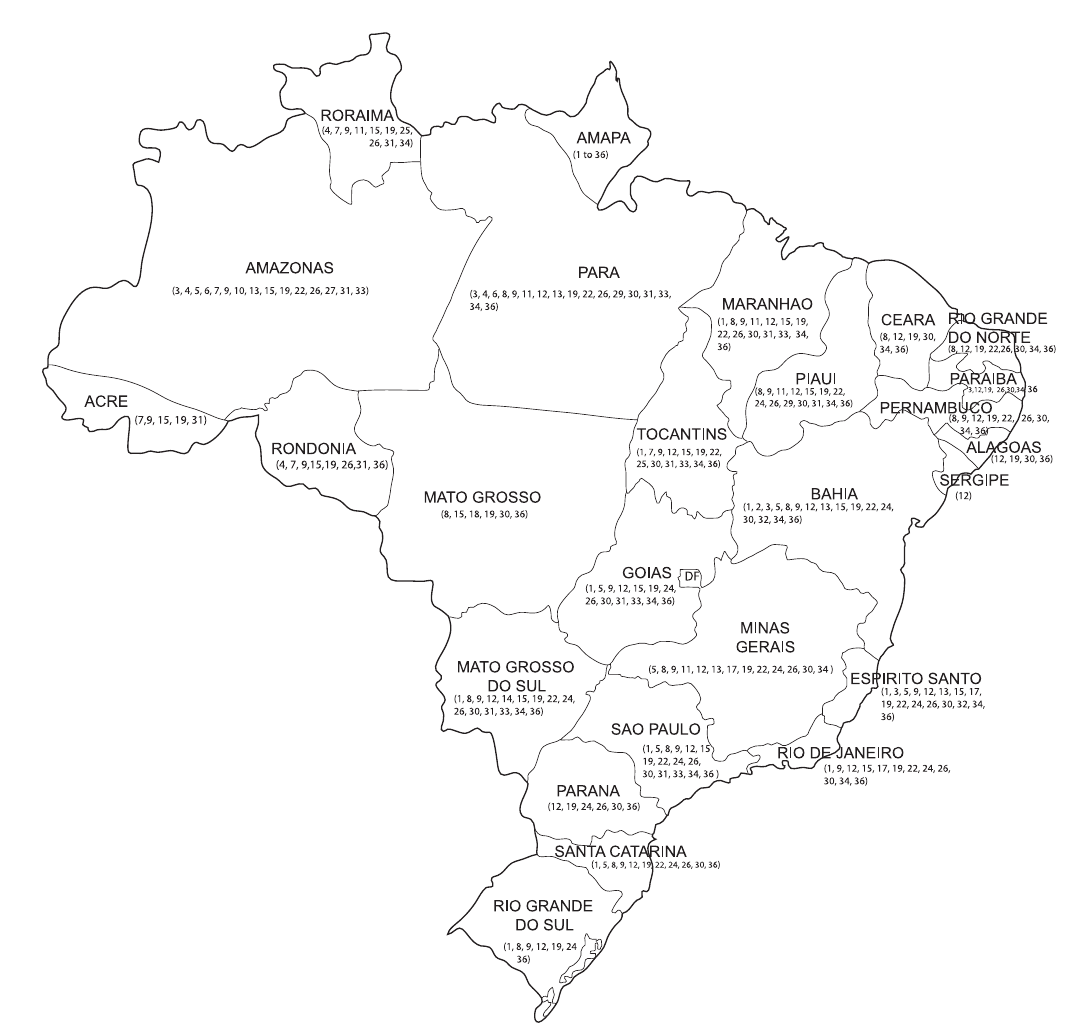
Figure 1. Geographic distribution in Brazil of the Anastrepha species reported from Amapá, based on the present study (species 1, 6, 7, 8, 9, 10, 11, 12, 13, 17, 18, 19, 20, 24, 25, 28, 30, 32) and on previous records: S ILVA et al. (2007), species 3, 4, 15, 16, 22, 26, 31, 33, 34, 35; J ESUS et al. (2008), species 21; Z UCCHI (2008), species 2, 5, 14, 23, 27, 29; U CHÔA & N ICÁCIO (2010), species 36; and P EREIRA et al. (2010), species 7 and 9 from states of Acre and Rondônia. Legend: (*1) Anastrepha amita , (2) A . anomala , (3) A . antunesi , (4) A . atrigona , (5) A . bahiensis , (6) A . binodosa , (7) A . coronilli , (8) A . dissimilis , (9) A . distincta , (*10) A . duckei , (*11) A . flavipennis , (12) A . fraterculus , (13) A . furcata , (14) A . hastata , (15) A . leptozona , (16) A . limae , (*17) A . minensis , (18) A . mixta , (19) A . obliqua , (20) A . oiapoquensis , (21) A . parishi , (22) A . pickeli , (23) A . pseudanomala , (*24) A. pseudoparallela , (25) A . rafaeli , 26. A . serpentina , 27. A . shannoni , (28) A . siculigera , (29) A . sodalis , (30) A . sororcula , (31) A . striata , (*32) A . submunda , (33) A . turpiniae , (34) A . zenildae , (35) Bactrocera carambolae , (36) Ceratitis capitata . *New records for the state of